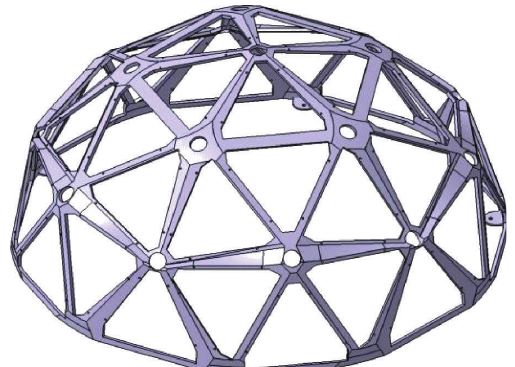
Figure 13: Antenna structure.